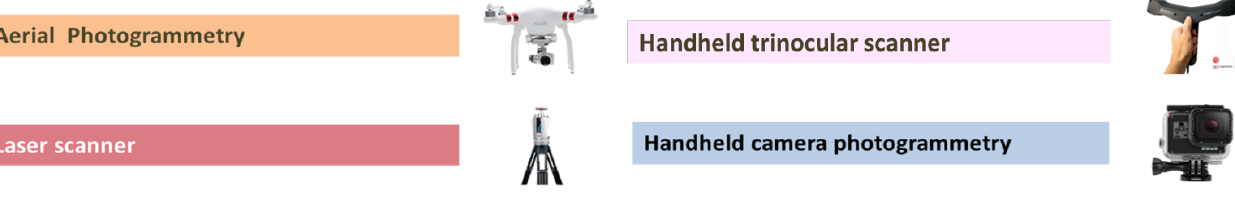
Figure 2. 3D digitization modalities.